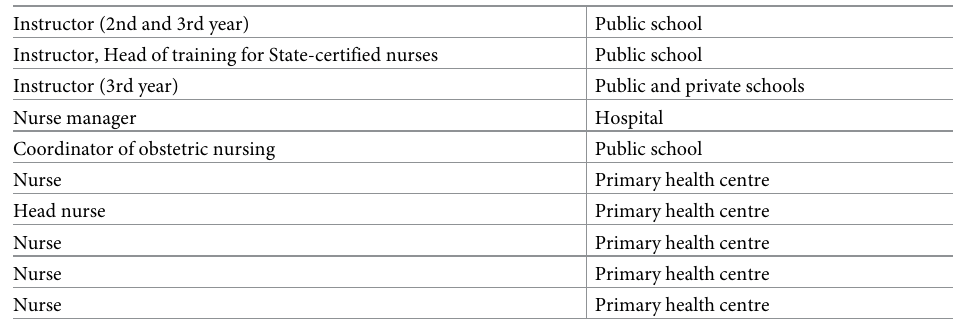
Table 3. Description of persons interviewed (n =